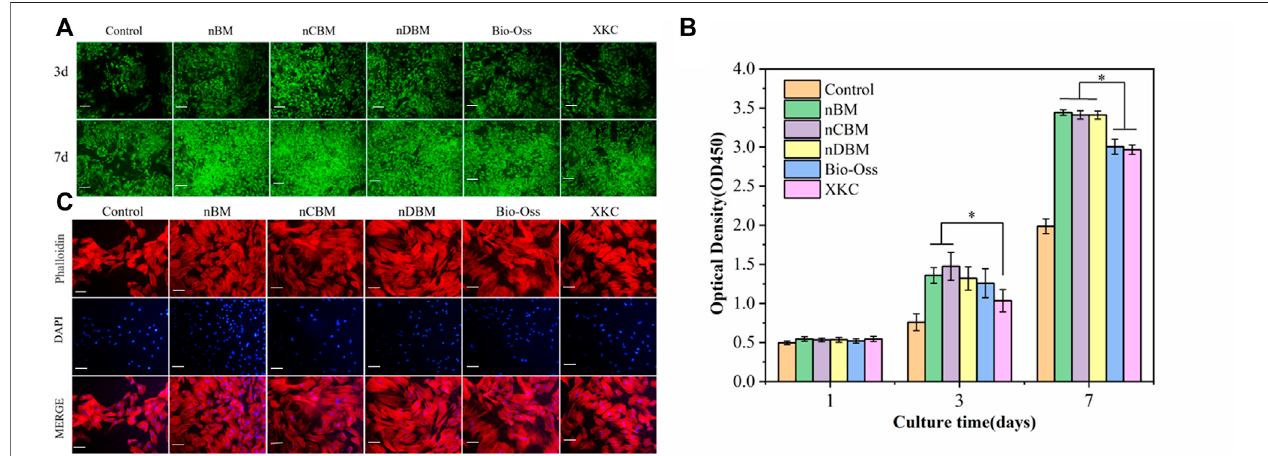
FIGURE 9 | (A) Fluorescence of bone marrow mesenchymal stem cells (BMSCs) on different bone powders at 3 and 7 days, stained with Calcein-AM (green, live cells). Scale bars: 200 μ m. (B) Cell proliferation of different bone powders, * p < 0.05. (C) Morphology of BMSCs on different bone powders at 3 days, stained with phalloidin (cytoplasm, red) and DAPI (nucleus, blue). Scale bars: 100 μ m.